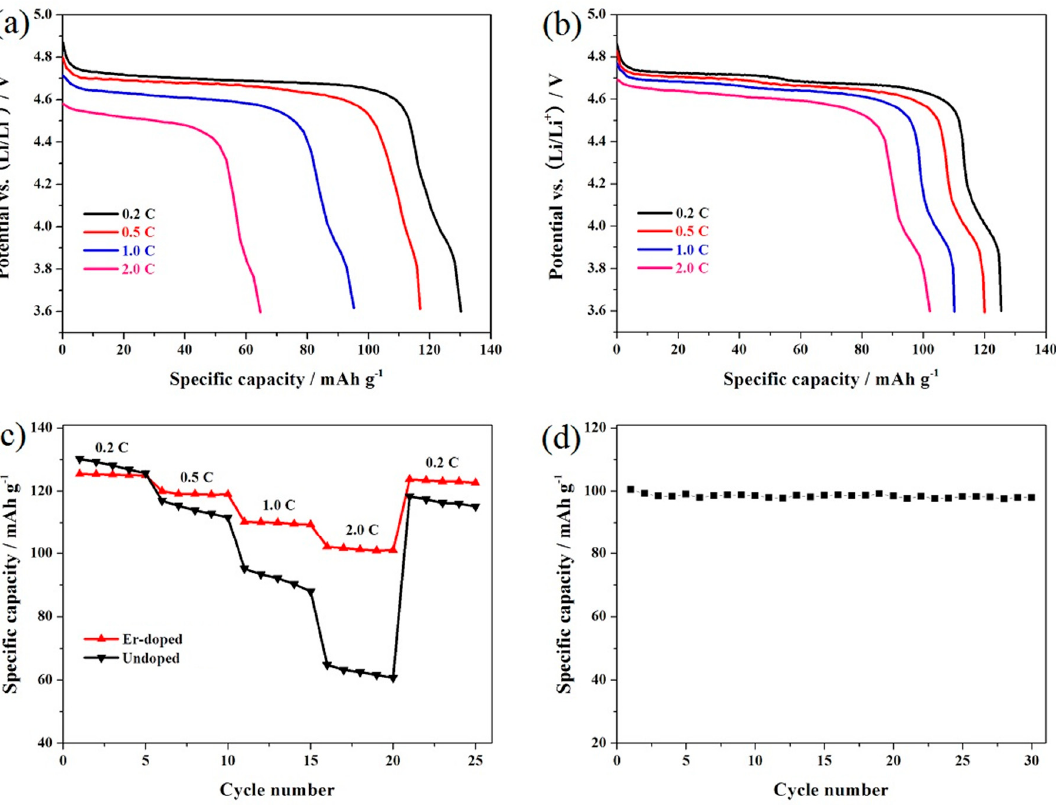
Figure 6. Representative discharge curves of the LiNi 0.5 Mn 1.5 O 4 ( a ) and Er-doped LiNi 0.5 Mn 1.5 O 4 ( b ) at different rates; ( c ) rate capability of the LiNi 0.5 Mn 1.5 O 4 and Er-doped LiNi 0.5 Mn 1.5 O 4 ; ( d ) cycling stability of the Er-doped LiNi 0.5 Mn 1.5 O 4 at 2.0 C.